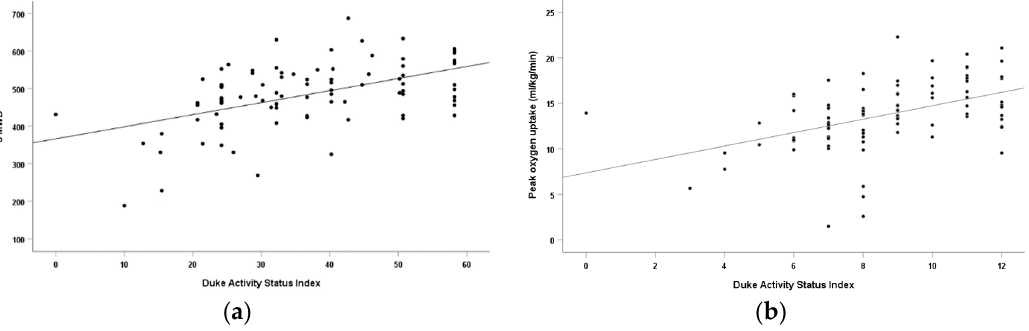
Figure 2. ( a ) The association between the DASI score and peakVO 2 in PAH patients. ( b ) The association between the DASI score and 6MWD in PAH patients.